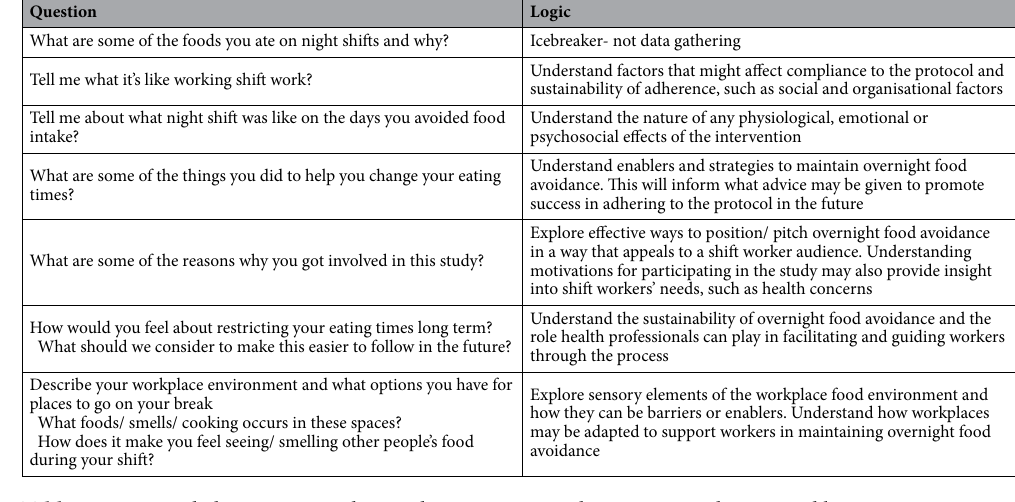
Table 1. Open ended questions used to guide semi-structured interviews and associated